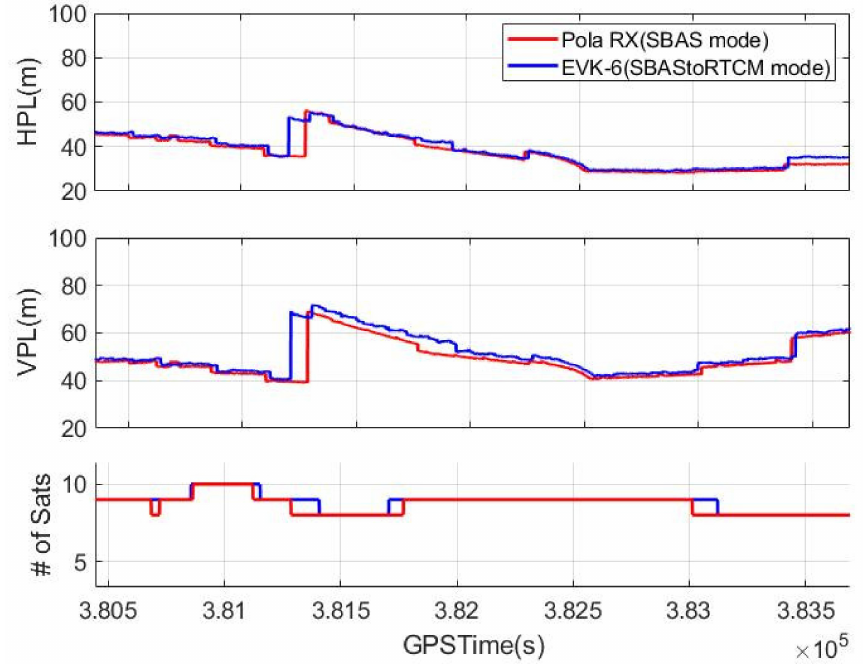
Figure 10. Protection level comparison ( top : horizontal protection level (HPL), middle : vertical protection level (VPL), bottom : number of active